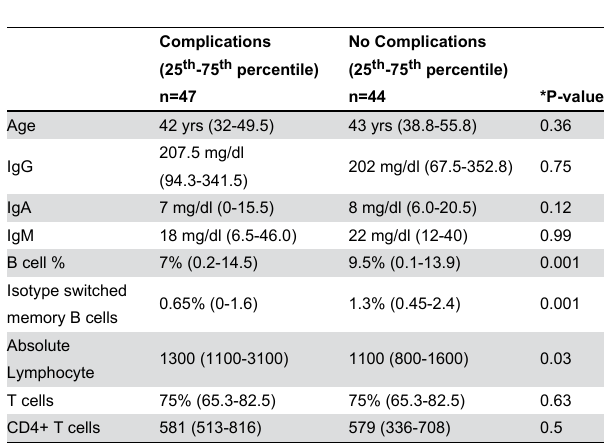
Table 2. Comparing CVID subjects with and without Inflammatory